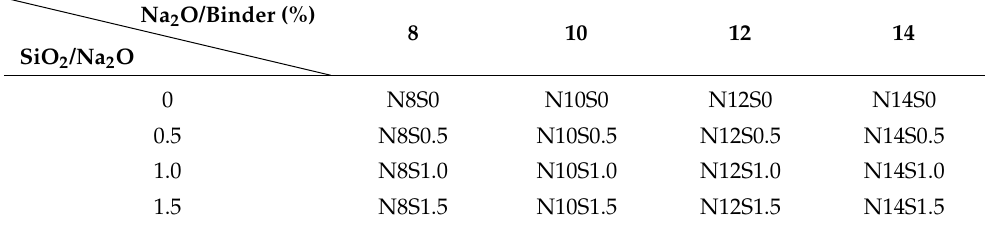
Table 1. Denomination of the alkaline solution of alkali-activated mixes.